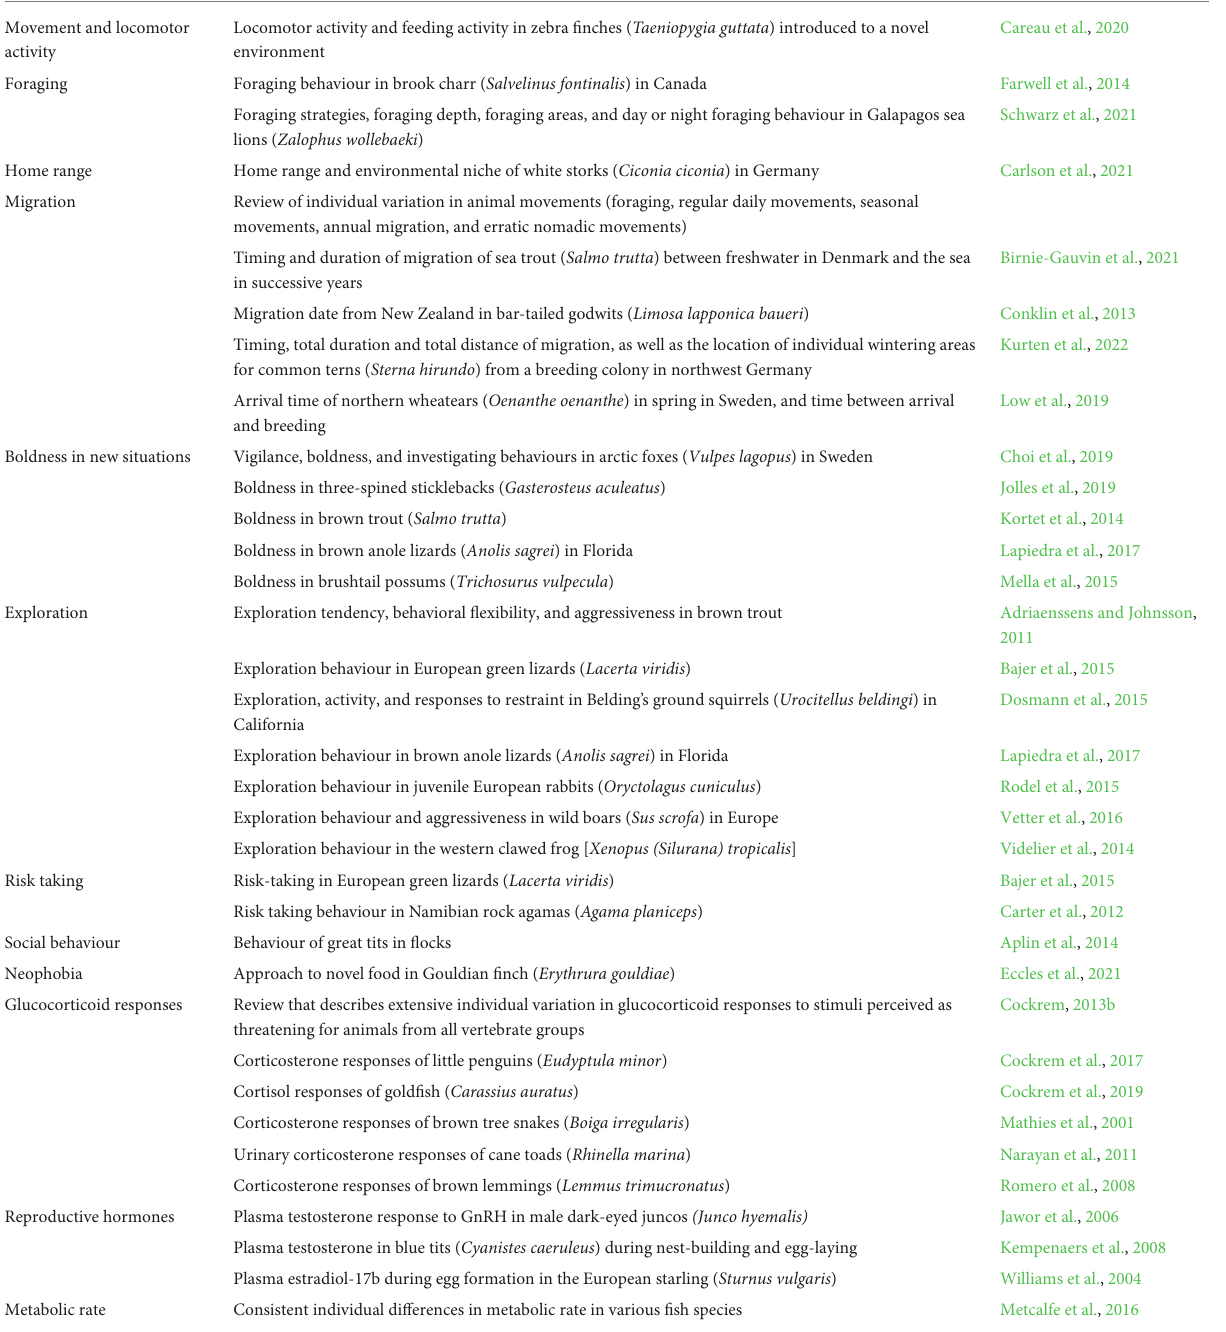
TABLE 2 Examples of individual variation in behavioural and physiological